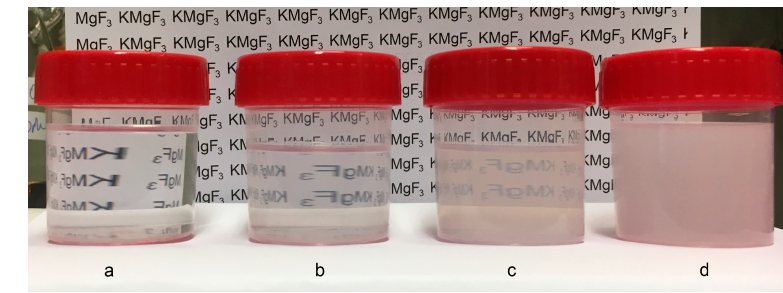
Figure 1. Comparison of visual appearances. ( a ) ethanol, ( b ) sol 12 , ( c ) sol 9 , ( d ) sol 10 .